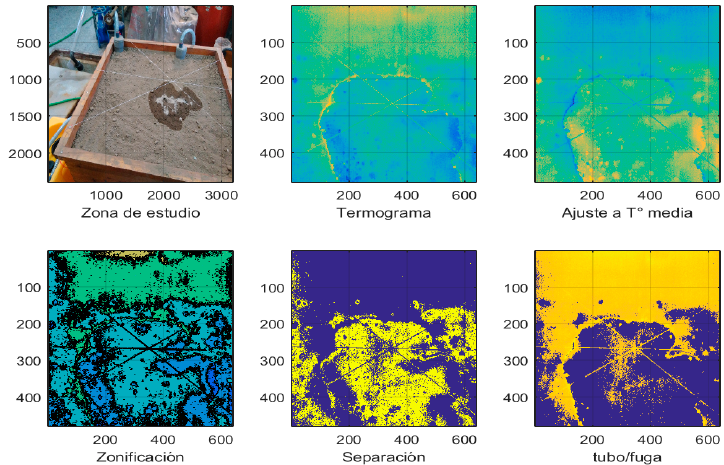
Figure A7. Termogram results with MATLAB algorithms. Test ID: Mr-4.